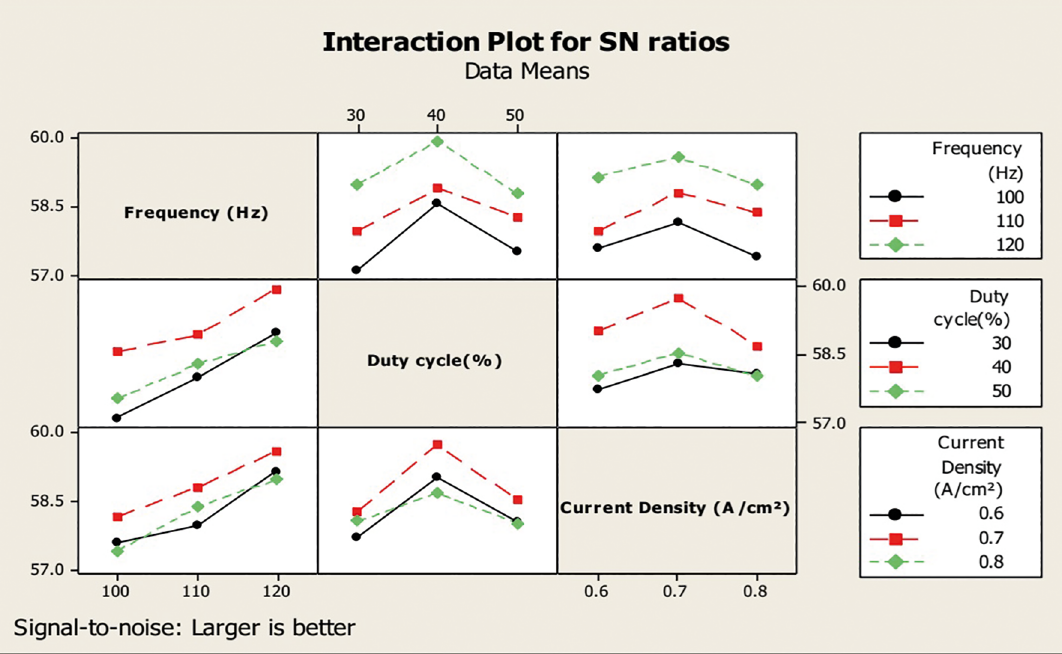
Figure 3. Interaction plot for microhardness (HV).